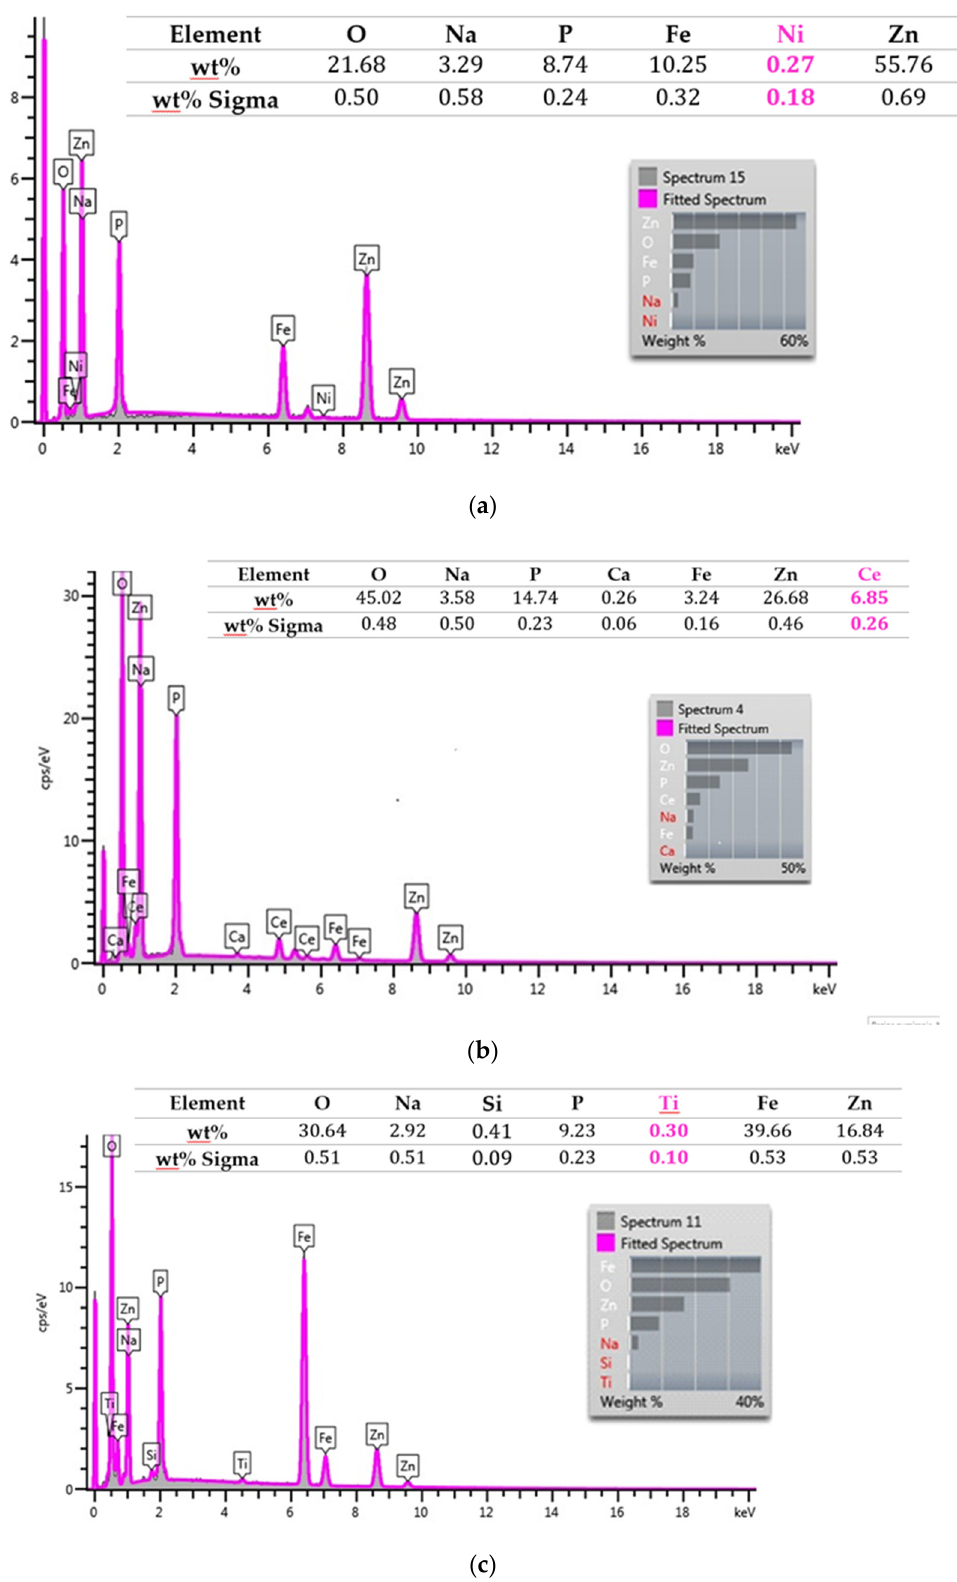
Figure 2. EDS analysis obtained from the surface of phosphate coatings with different pre-treatments processes: ( a ) Ni 2+ ions, ( b ) Ce 3+ ions, and ( c ) Ti 2+ ions.